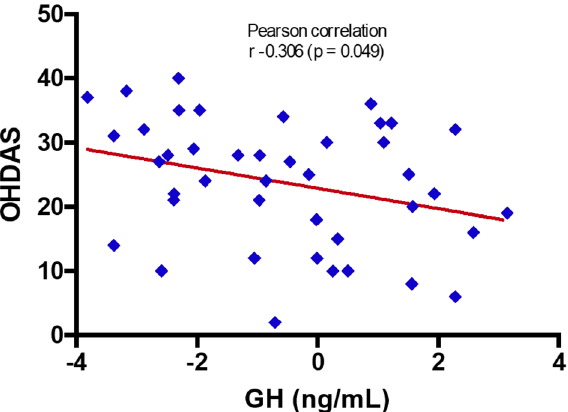
Figure 2. Correlation between circulating growth hormone levels and OHDAS score. GH, growth hormone; OHDAS, OH daily